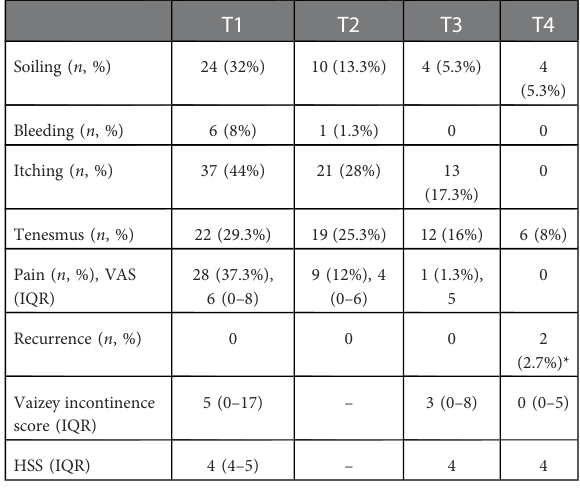
TABLE 3 Postoperative complications (T1 – T4): 1 week (T1), 2 weeks (T2), 1 month (T3), 6 months (T4) after surgery. VAS, visual analog scale; HSS, hemorrhoid severity score; IQR, interquartile range.